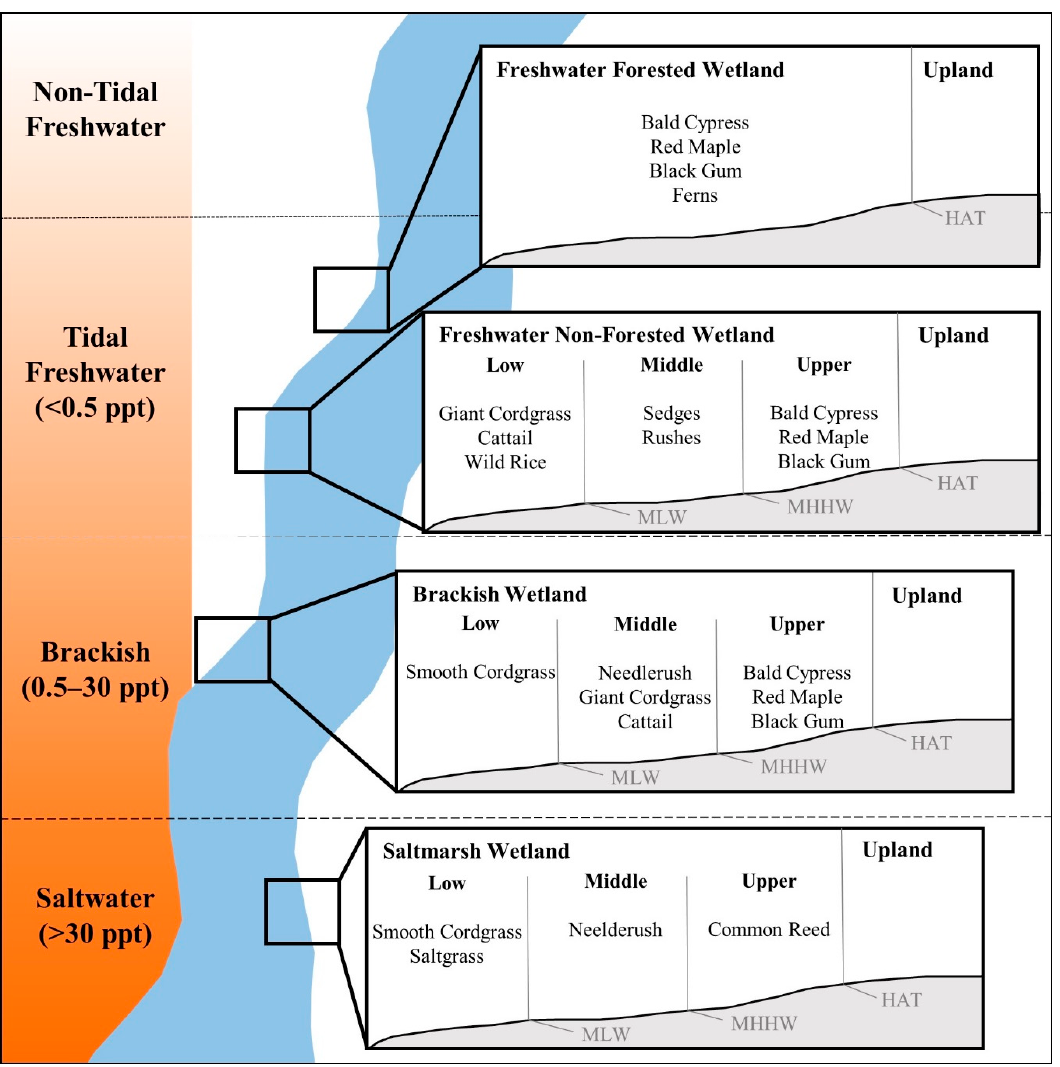
Figure 2. Conceptual model of coastal riverine wetlands in southeastern North Carolina describing the differences in salinity and species that occupy each type of wetland. Adapted from Cowardin et al., 1979 [28] , and Odum et al., 1984 [15] .